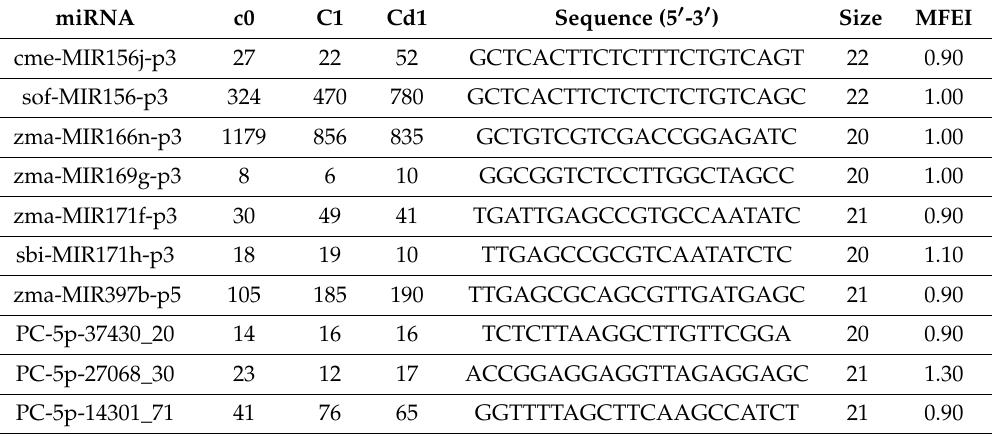
Table 1. Novel MicroRNAs (miRNAs) with high-confidence in maize xylem